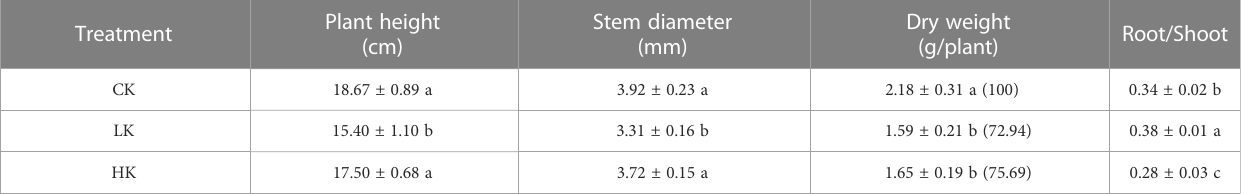
TABLE 1 The growth indexes in apple under control (CK), low-potassium (LK), and high-potassium (HK) conditions.